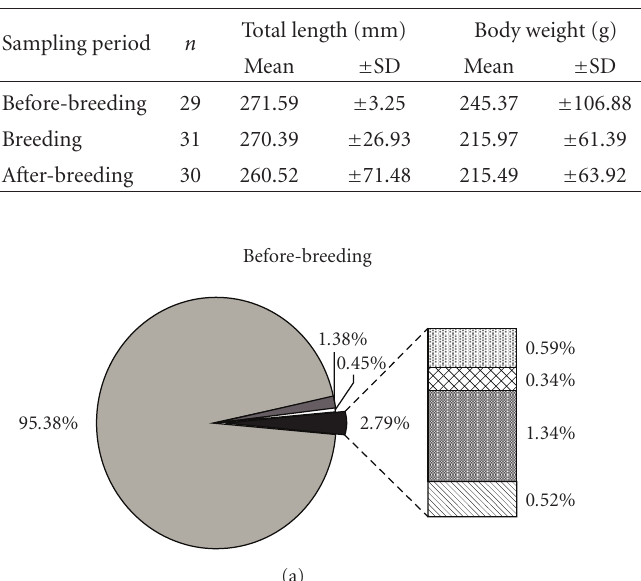
Table 1: Data on the fish investigated: n presents the number of males collected, total body length, body weight, gonad weight, spleen weight, and condition factor ( K ): means ± SD are shown.